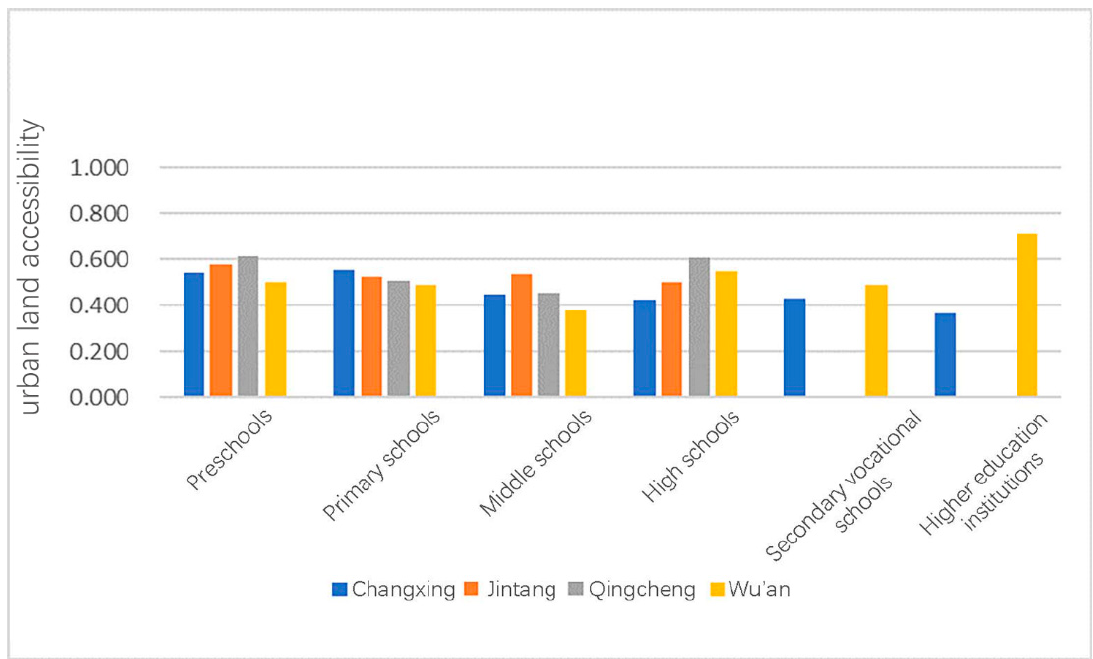
Figure 2. Graph of the average comprehensive urban land accessibility of locations of educational facilities at all levels in a typical county.